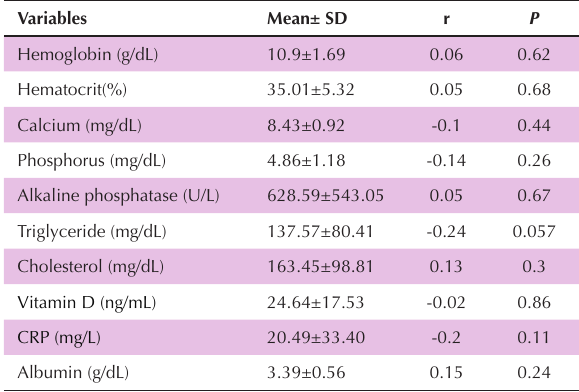
Table 2. Correlation between various biochemical parameters and irisin